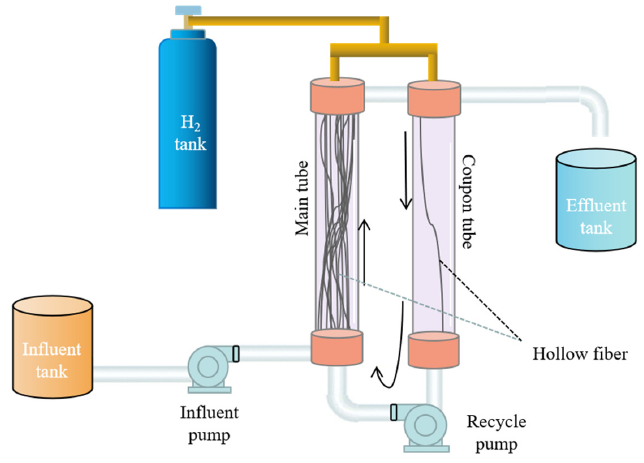
Figure 1. The composition and structure of the MBfR.